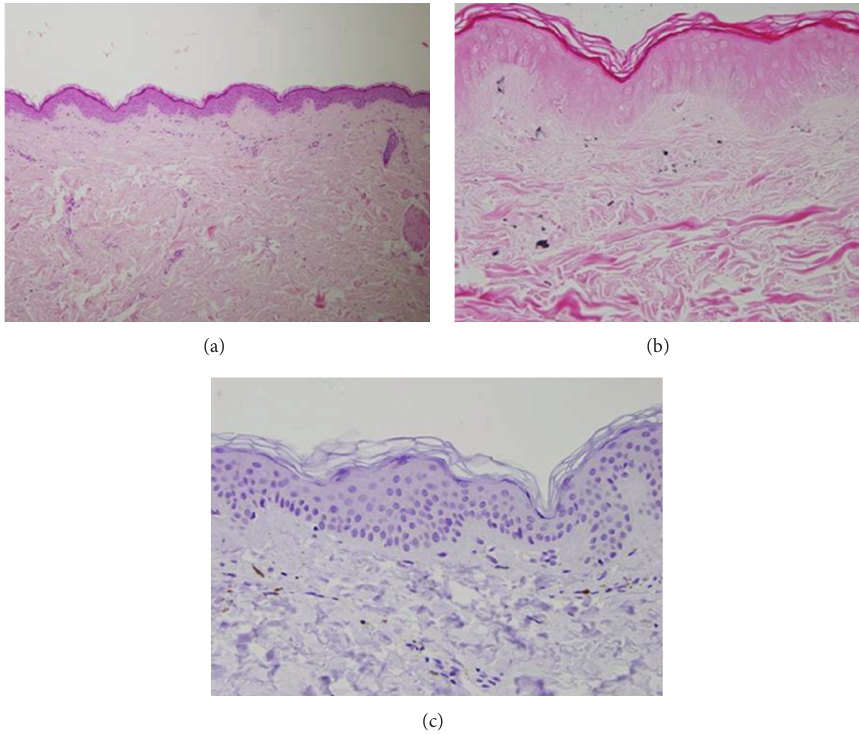
Figure 2: (a) Normal looking epidermis and dermis except that there is a lack of melanin pigment in the epidermis. (H&E × 100). (b) Fontana stain shows lack of melanin pigment in the epidermis and several melanophages in the papillary dermis ( × 400). (c) MART-1 immunostain shows lack of melanocytes in the epidermis ( ×